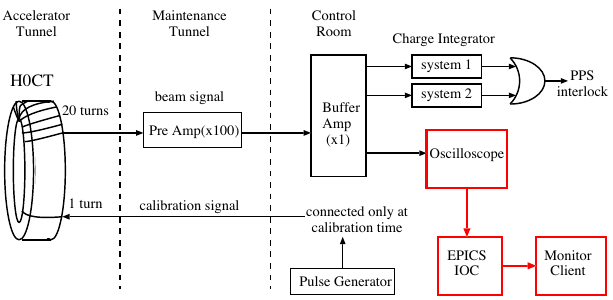
FIG. 6. The geometrical parameters and the drawing of the MWPM wire configuration at the u and v planes for simulta- neously measuring the horizontal and vertical beam profiles,